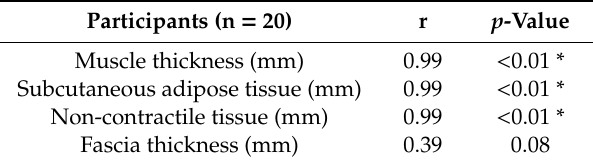
Table 2. Correlation between MRI and US measurements.